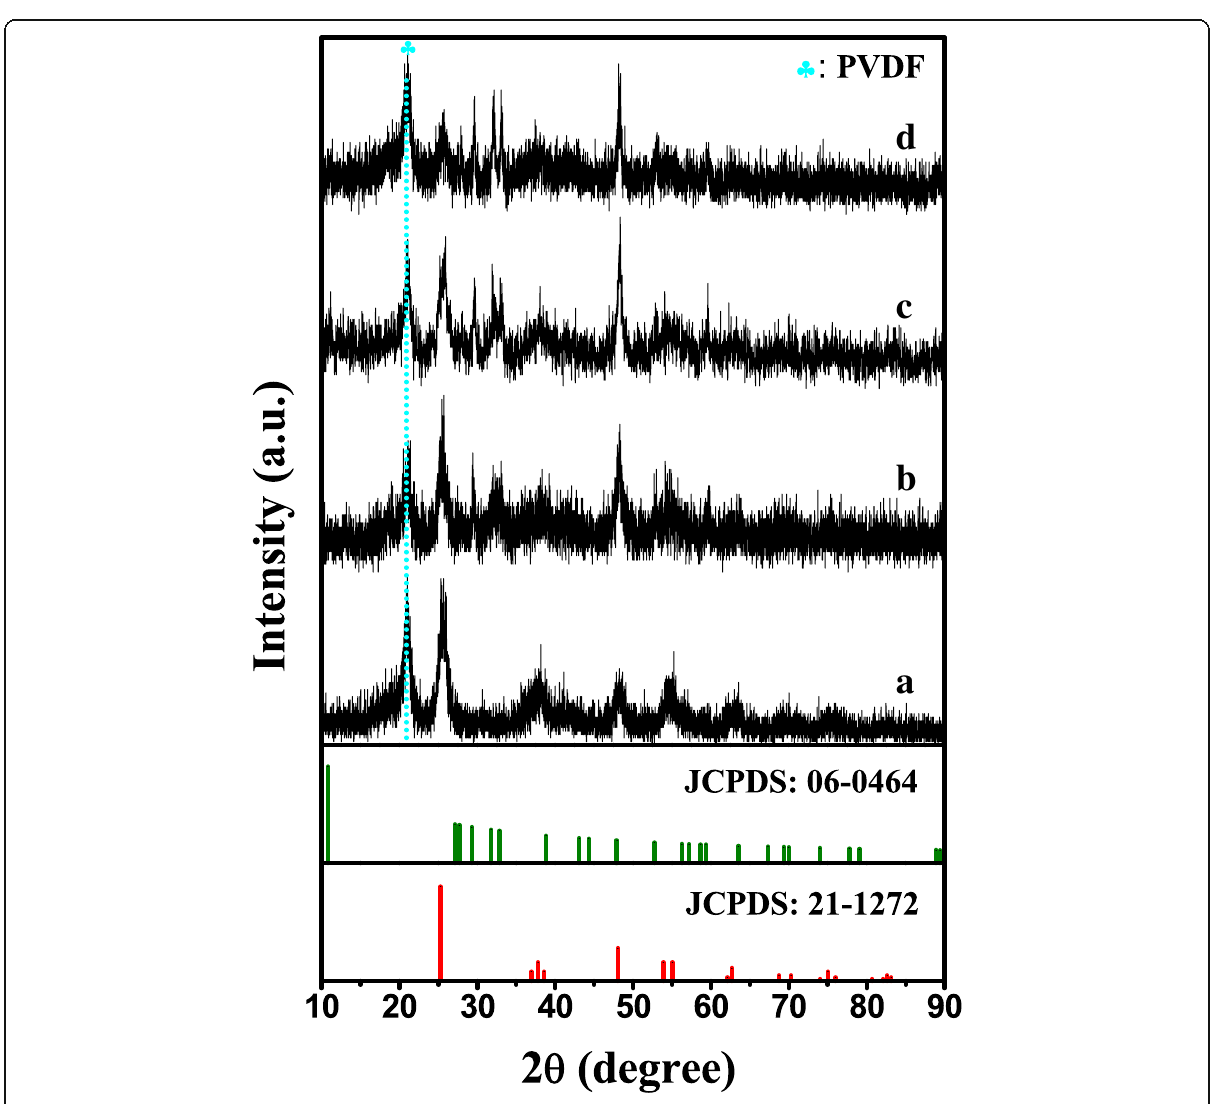
Fig. 1 XRD patterns of (a) TiO 2 /PVDF fibers, (b) Cu 0.1, (c) Cu 0.5, and (d) Cu